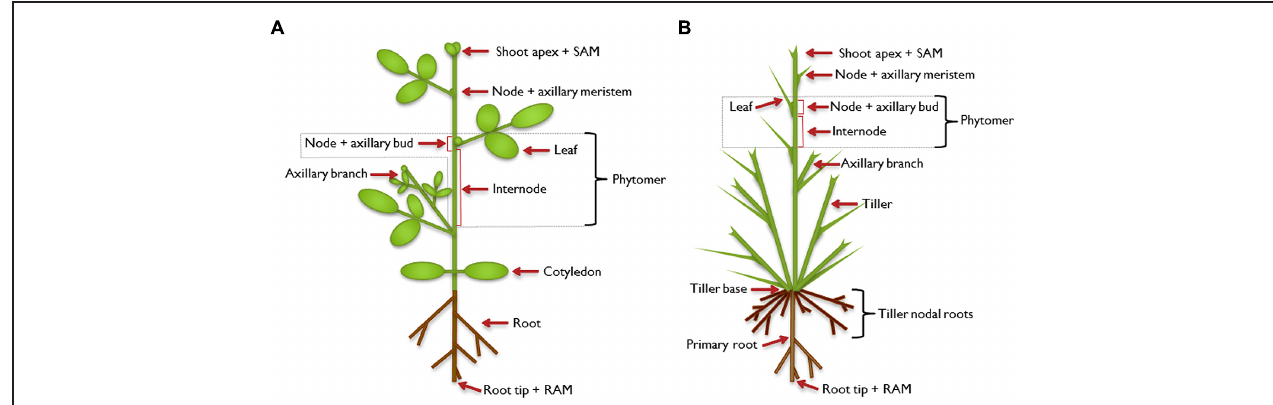
FIGURE 1 | Illustration of plant architecture. Typical architecture of a dicot plant (A) and a monocot plant (B) . The shoot apical meristem (SAM) establishes the shoot as the primary growth axis of the plant by continuously initiating phytomers, the basic modules of the plant shoot. A phytomer consists of an internode and a node with its attached leaf. In the leaf axils, axillary (secondary) meristems are formed in dicot and some monocot plants, which develop into an axillary bud and have the potential to continue growth to form an axillary